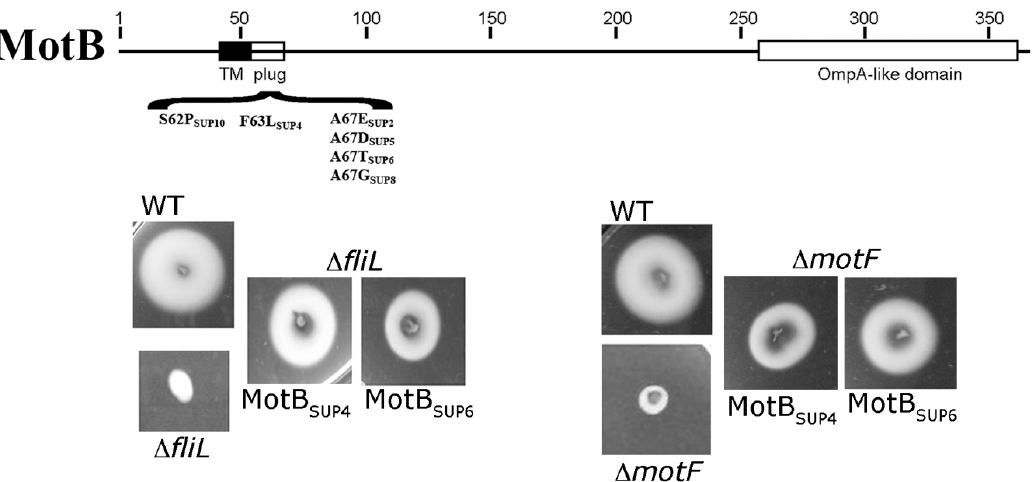
Figure 6. Scheme of the plug region of MotB showing the mutant alleles that suppress the Mot − phenotype of ∆ fliL and ∆ motF . Also shown are the swimming phenotypes on soft agar of the various strains and suppressor mutants [34,56,102].